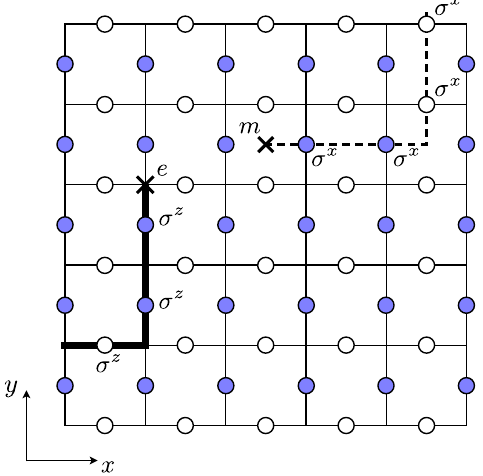
FIG. 4. The toric code with an unconventional Z 2 × Z 2 symmetry that exhibits “ anyonic spin-orbit coupling. ” Dots represent qubits on each bond; the dark blue ones transform as projective representations of the global Z 2 × Z 2 symmetry, while the light dots do not. The string operators that move the e particles vertically (thick black line) and m particles horizontally (dashed black line) involve operators on vertical links, so are charged under the symmetry